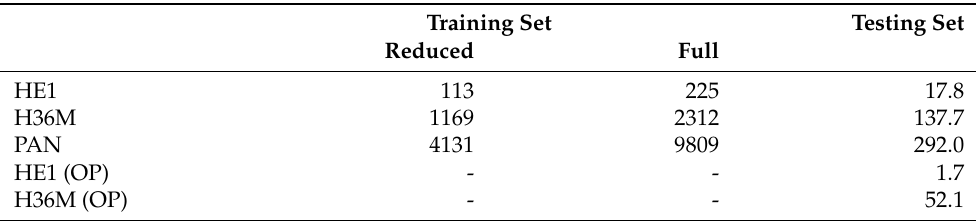
Table 6. Sample sizes in thousands of